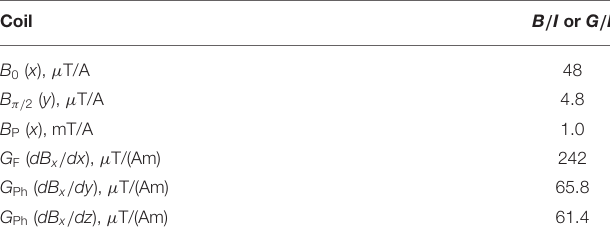
TABLE 1 | Coil parameters of the PTB ULF-MRI system.